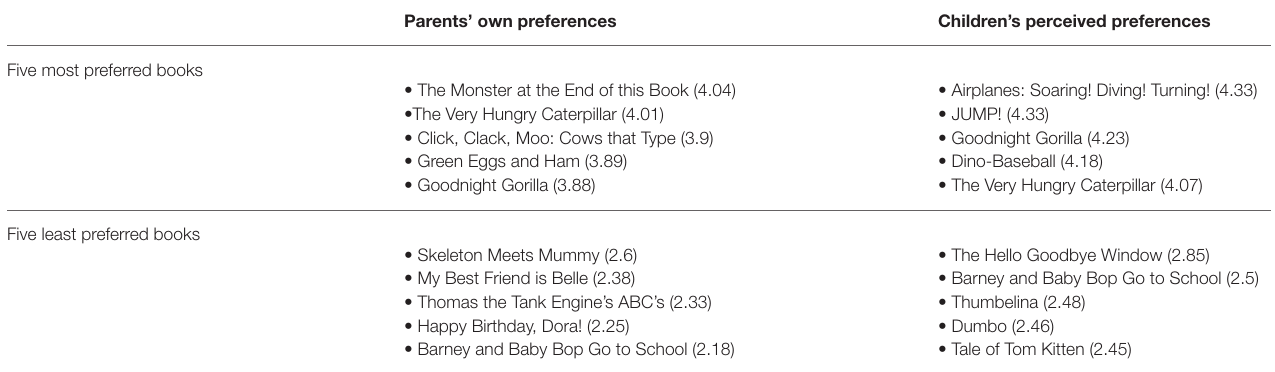
TABLE 3 | Most and least preferred books.